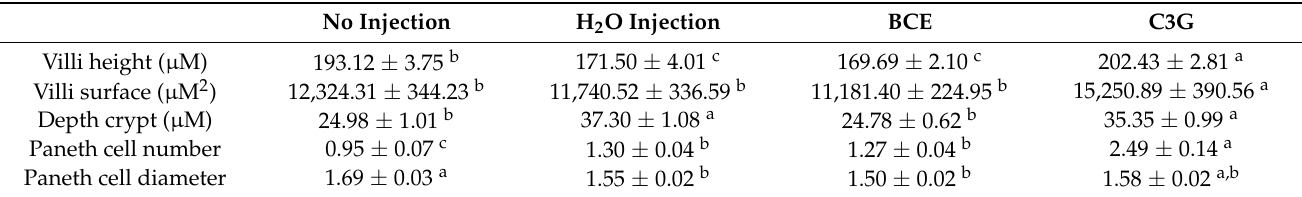
Table 3. Effect of intra-amniotic administration of black corn extract on villi height, surface, and depth